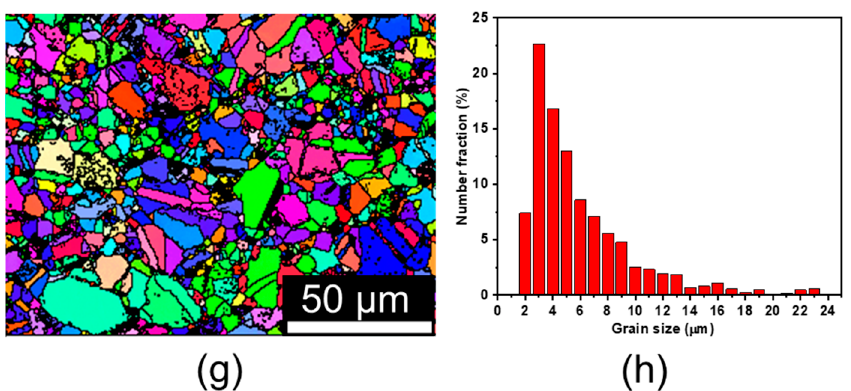
Figure 8. ( a – d ) Inverse pole figure (IPF) maps and ( e – h ) grain size distributions of the CS IN718 coatings obtained by EBSD characterization under different conditions: ( a , e ) 900 °C solution + double aging, ( b , f ) 950 °C solution + double aging, ( c , g ) 1000 °C solution + double aging, and ( d , h ) 1050 °C solution + double aging.